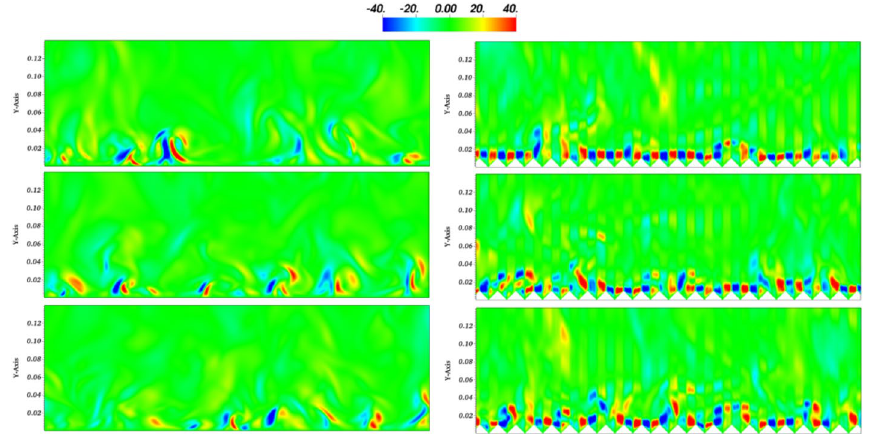
Fig. 18 Distribution of wall-normal vorticity fluctuation w y ’ in three moments (Left: smooth flat-plate case; Right: riblets-controlled